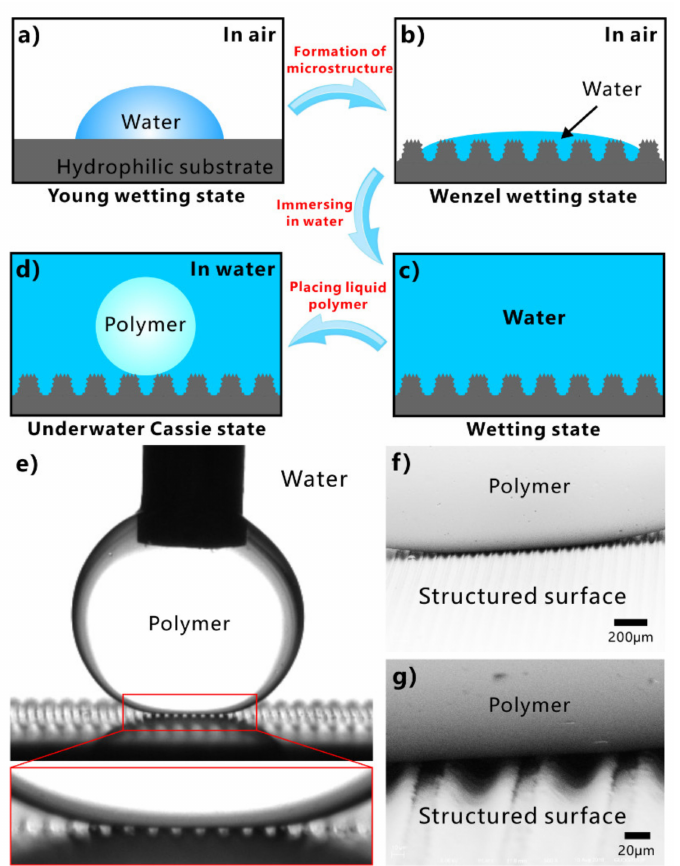
Figure 22. Formation mechanism of the underwater superpolymphobicity. ( a ) Water droplet on a smooth hydrophilic substrate. ( b ) Water fully wetting the structured surface. ( c ) The rough surface in a water medium. ( d ) Wetting state of a liquid polymer droplet on the rough surface in water. ( e ) Enlarged optical microscope image of the interface between the liquid polymer and the superpolymphobic microstructure in water. ( f , g ) SEM images of a droplet of liquid polymer (PDMS) on the sample surface after solidifying the polymer and removing the water environment. Reprinted from ref.